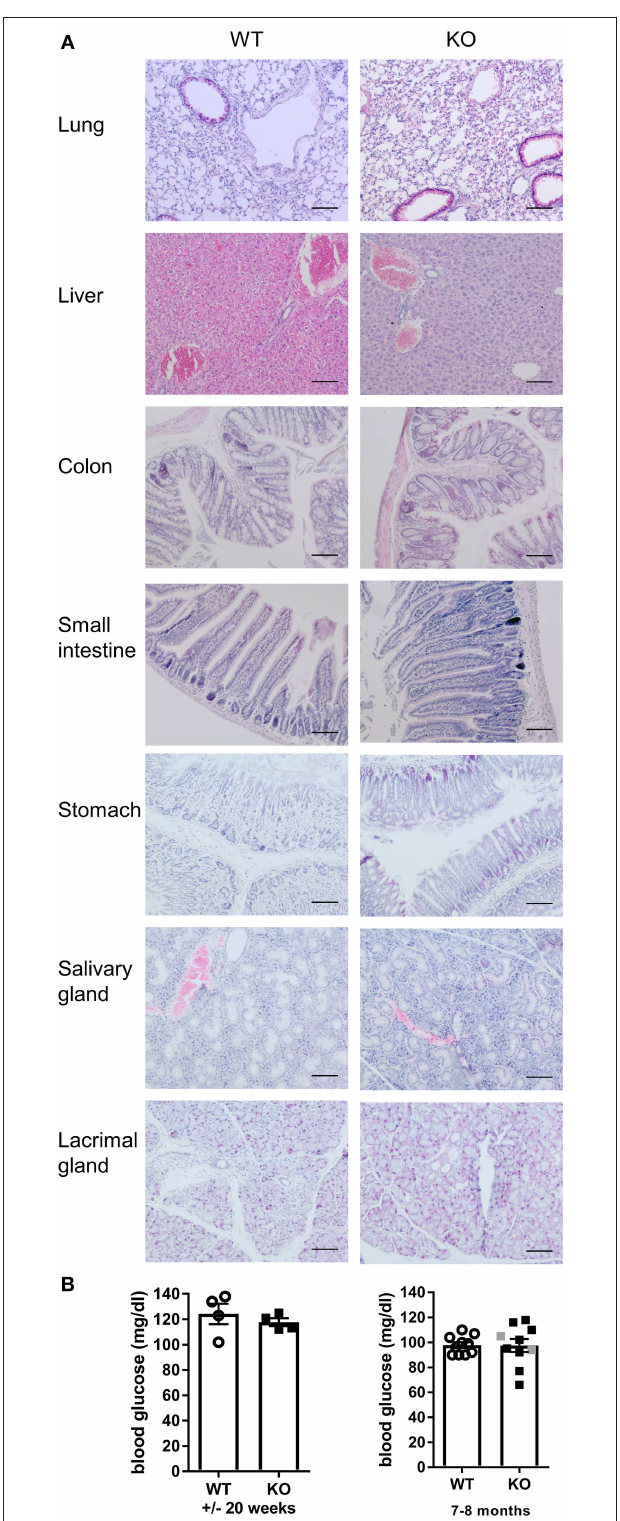
FIGURE 2 | Malt1 -KO mice do not develop multi-organ inflammation. (A) H&E staining (scale bar 100 µ m) of several organs from WT and Malt1 -KO mice